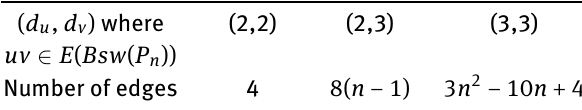
Table 3: The edge partition of the graph Bsw ( P n